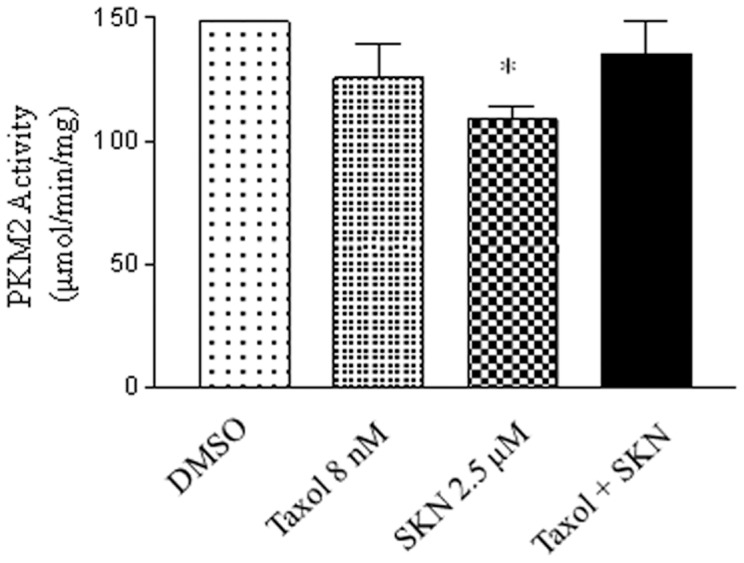
Enzymatic activity of PKM2 was measured from cells treated with DMSO as the vehicle control, taxol (8 nM), shikonin (2.5 μM), and the combination.*, p<0.05 compared to the control group. The experiments have been repeated more than three times.